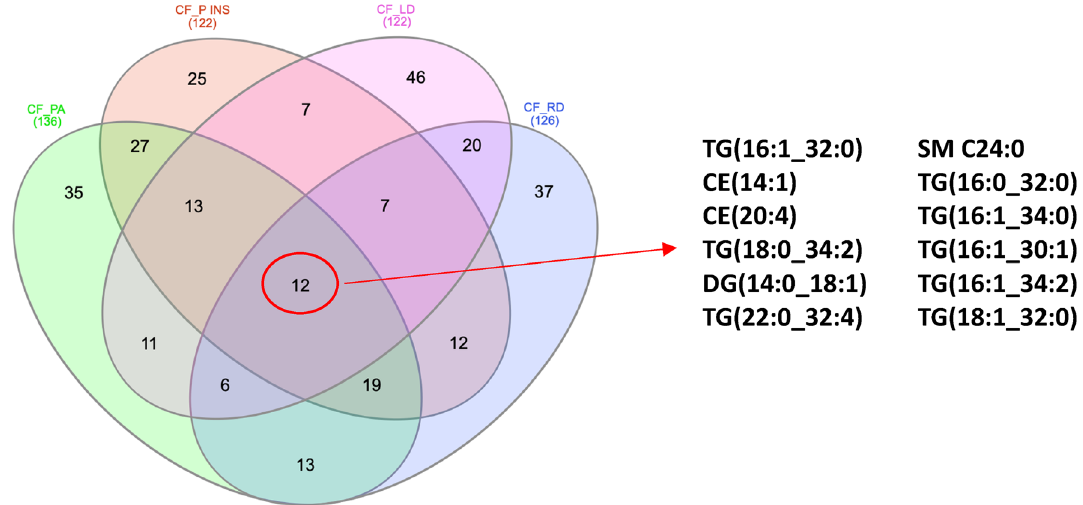
Figure 6. Eulero-Venn diagram reports the common lipids characterizing by a discriminat VIP score (VIP > 1) in four phenotypic groups CF_PA, CF_P INS, CF_LD and CF_RD groups. The 12 common molecules are